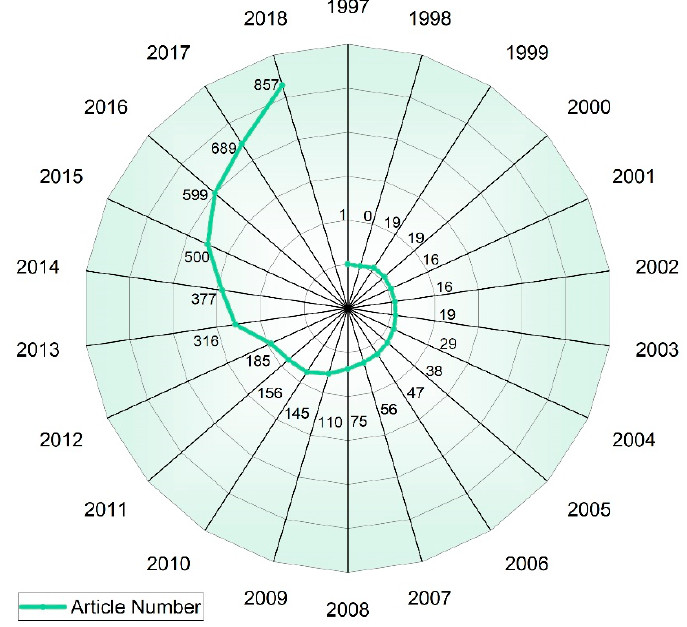
Figure 2. The number of published articles per year with keywords in the topic.